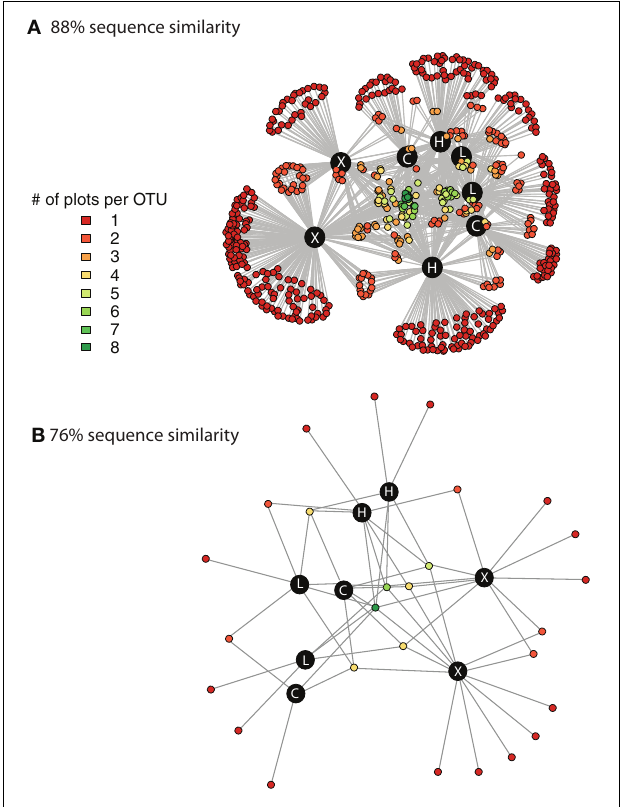
FIGURE 3 | Network graph displaying the connectivity among marsh plots derived from clustering at 88% sequence similarity (A) and at 76% sequence similarity (B). The different colors indicate the number of different plots that contain each individual OTU. The black circles denote the 8 marsh plots and the white lettering indicates the treatment level of the plot. C, control; L, Low dose; H, High dose; and X, extra high dose.